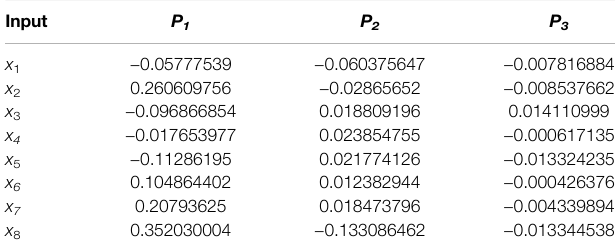
TABLE 3 | Parameters of the i th network in autumn prediction result.